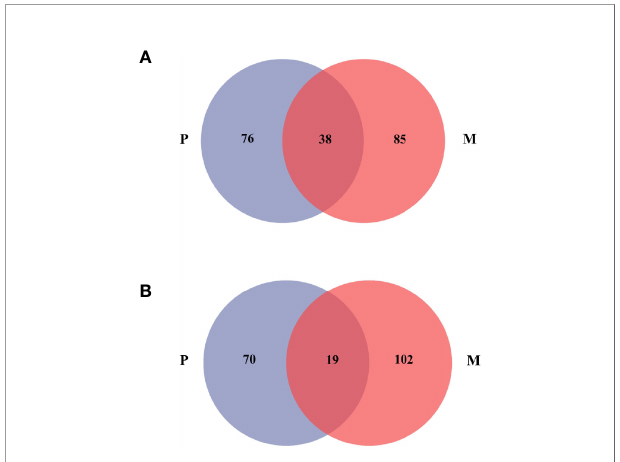
FIGURE 3 | Distribution of OTUs of the stomach contents of P.trituberculatus and M.japonicus in the PM (A) and PMS (B) systems. Blue circle represents P.trituberculatus and red circle represents M.japonicus .